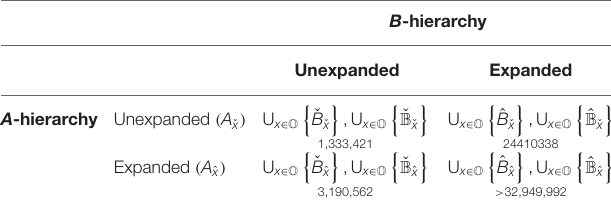
TABLE 1 | Variants of using Wikidata items to identify Wikipedia articles as vertices of INs.